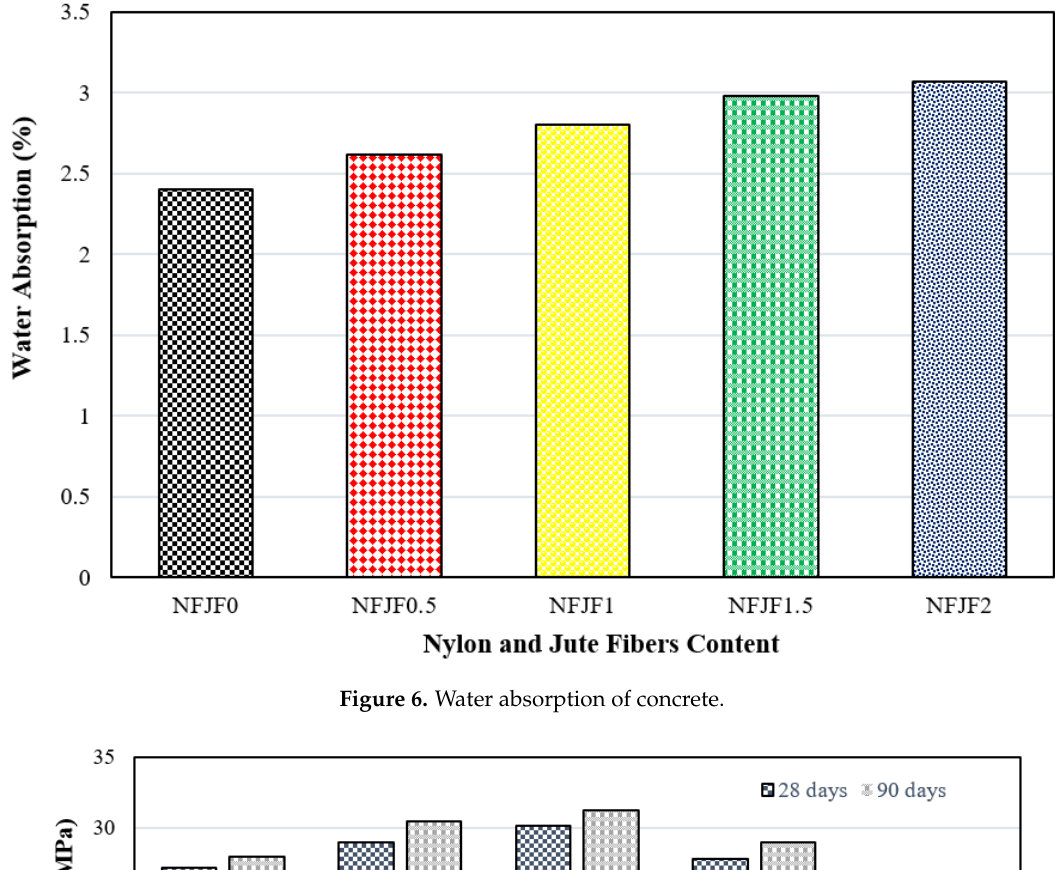
Figure 6. Water absorption of concrete.